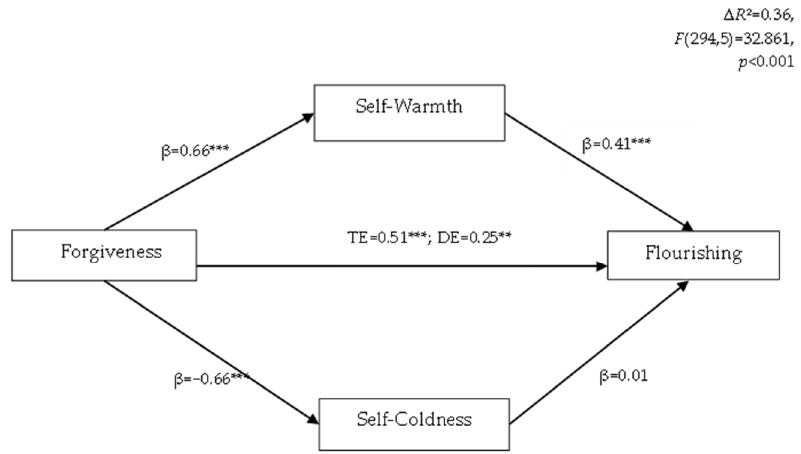
Figure 1. Parallel mediation model of forgiveness on flourishing using self-warmth and self-coldness as mediators. Standardized coefficients are presented. ** p < 0.01, *** p < 0.001; TE—total effect; DE—direction effect.